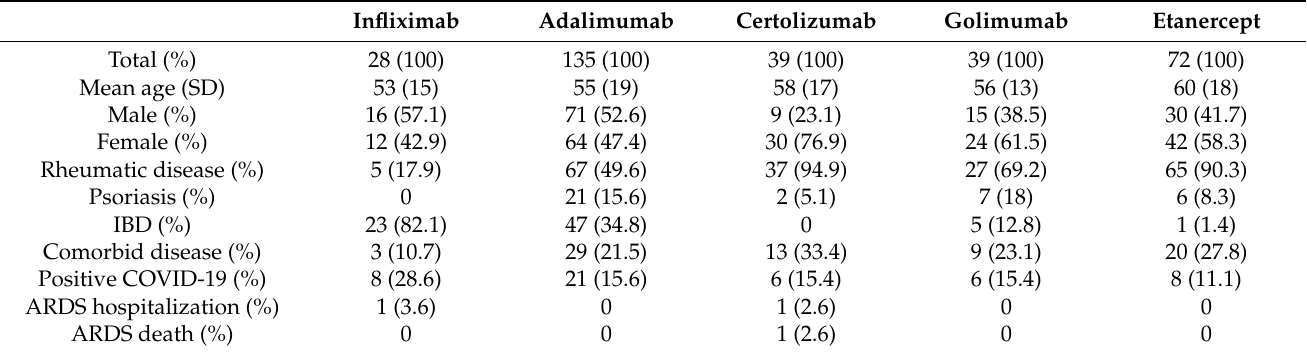
Table 1. Characteristics of patients treated with anti-TNF α . Infliximab